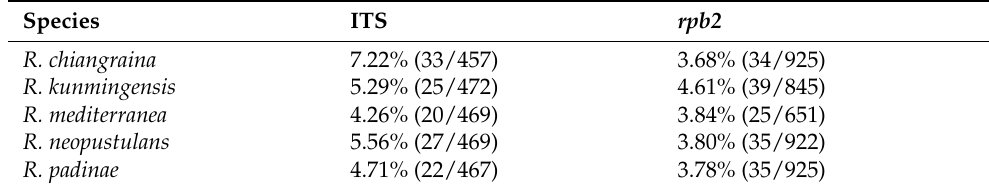
Table 6. Base pair differences of ITS and RPB2 gene loci of R. uniloculata and other related species.